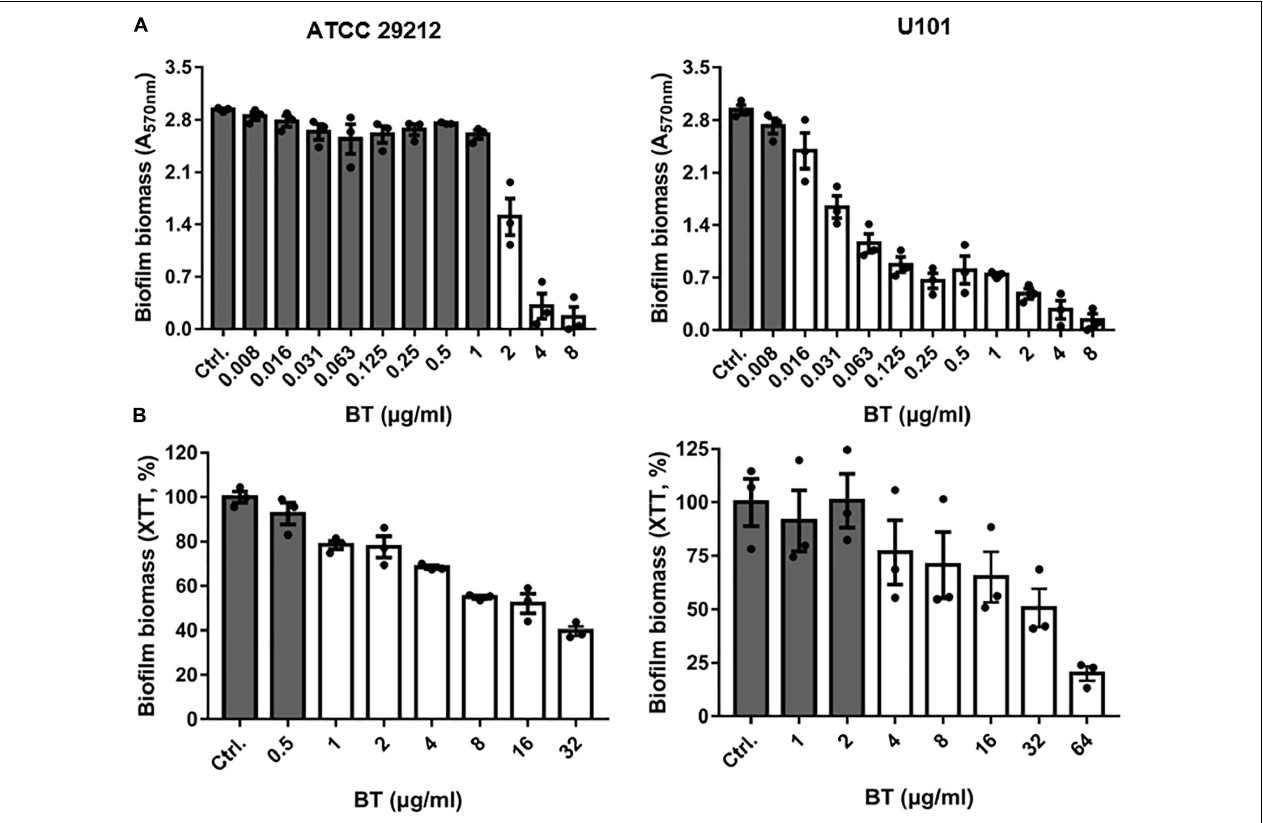
FIGURE 6 | Antibiofilm effects of BT against Enterococcus . (A) Dose-dependent biofilm inhibition of BT using crystal violet staining. (B) Dose-dependent biofilm eradication of BT using XTT staining. The white column indicates p < 0.05 compared with the control group.